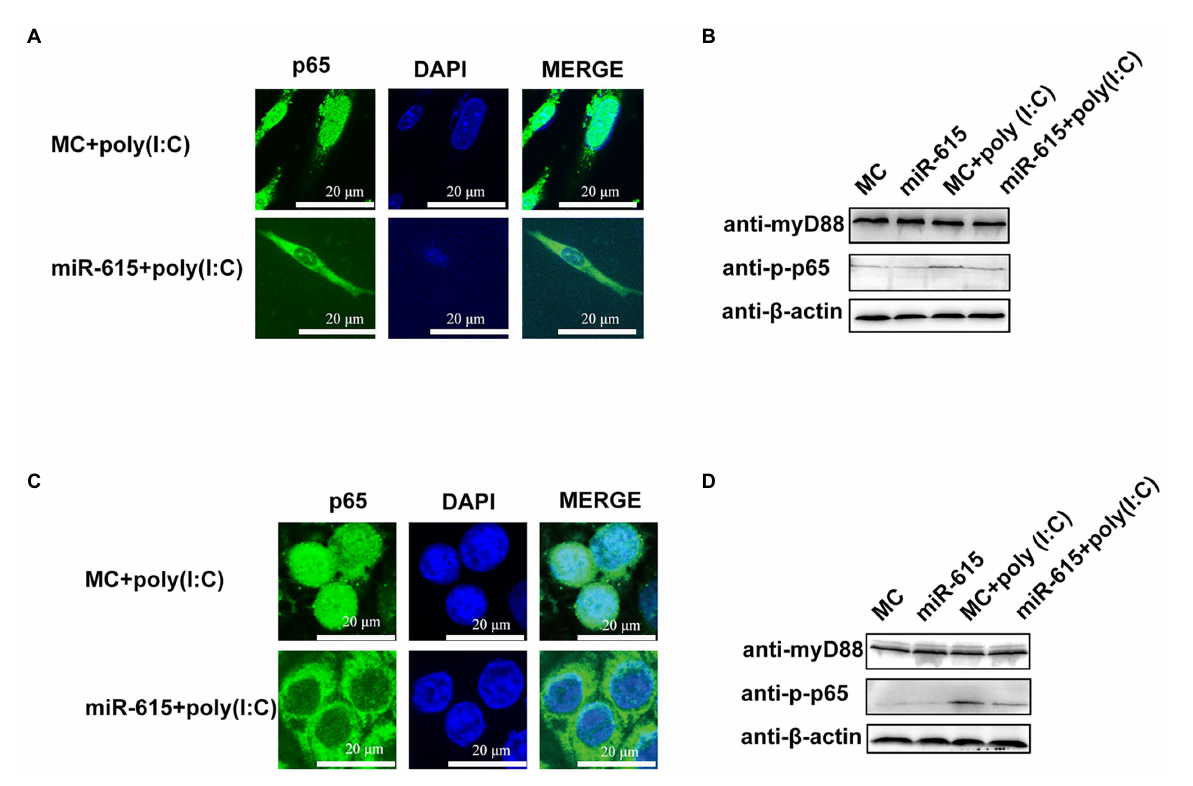
FIGURE 5 miR-615 inhibits the nuclear translocation and downregulates the phosphorylation of p65. (A,C) Immunofluorescence analysis of the nuclear translocation of p65 protein after transfection of miR-615 mimics during PEDV infection in IECs and MARC-145 cells. IECs and MARC-145 cells were transfected with miR-615. Poly (I:C) stimulation was added for 24 h during PEDV infection. Cells were fixed and stained with a rabbit anti- phosphorylated (p)-p65 and MyD88 monoclonal antibodies. Scale bar = 15 μ m. (B,D) Western blot analysis for detection of the (p)-p65 and MyD88